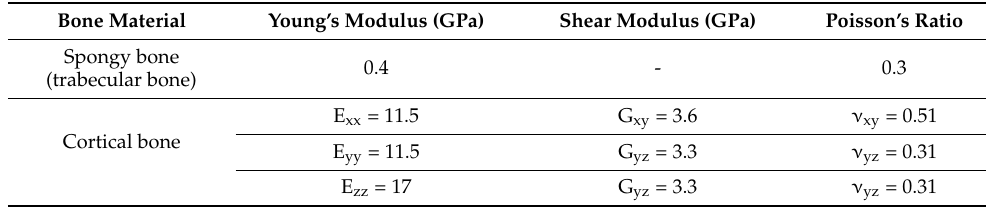
Table 2. Femur material properties utilized for the finite element model [21,33] (Hedayati et al., 2016; AA Oshkour et al.,